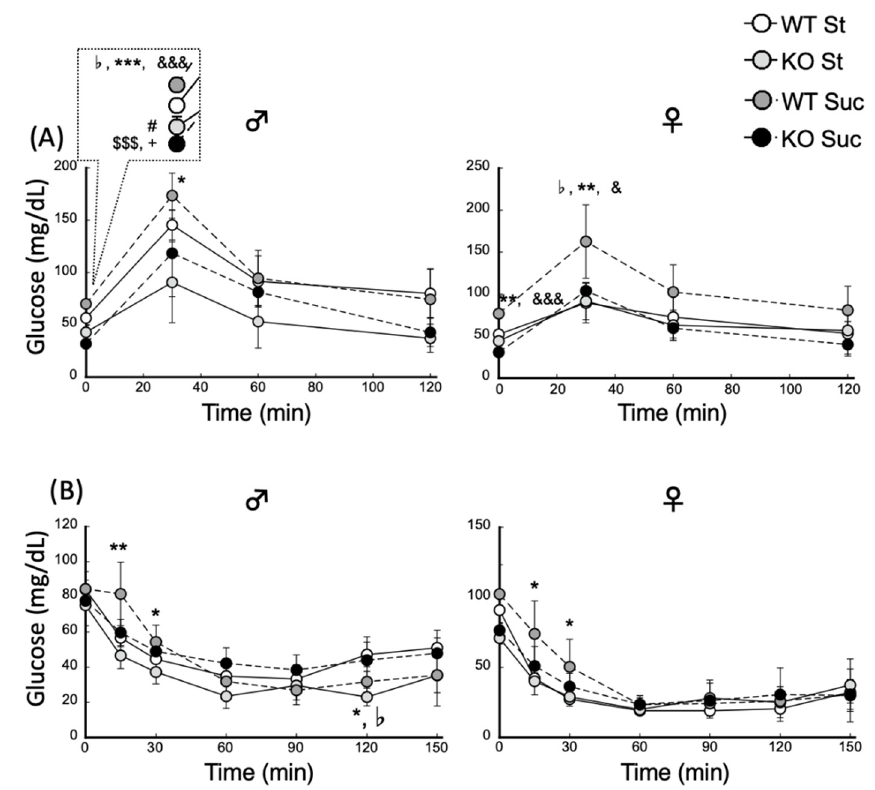
Figure 5. GTT and ITT according to diet in wild-type and PPAR α − / − mice. ( A ) Blood glucose con- centrations during the GTT. ( B ) Blood glucose concentrations during the ITT. # p < 0.05 between Wt St and KO St, ♭ p < 0.05 between WT St and WT Suc; $$$ p < 0.001 between Wt St and KO Suc; * p